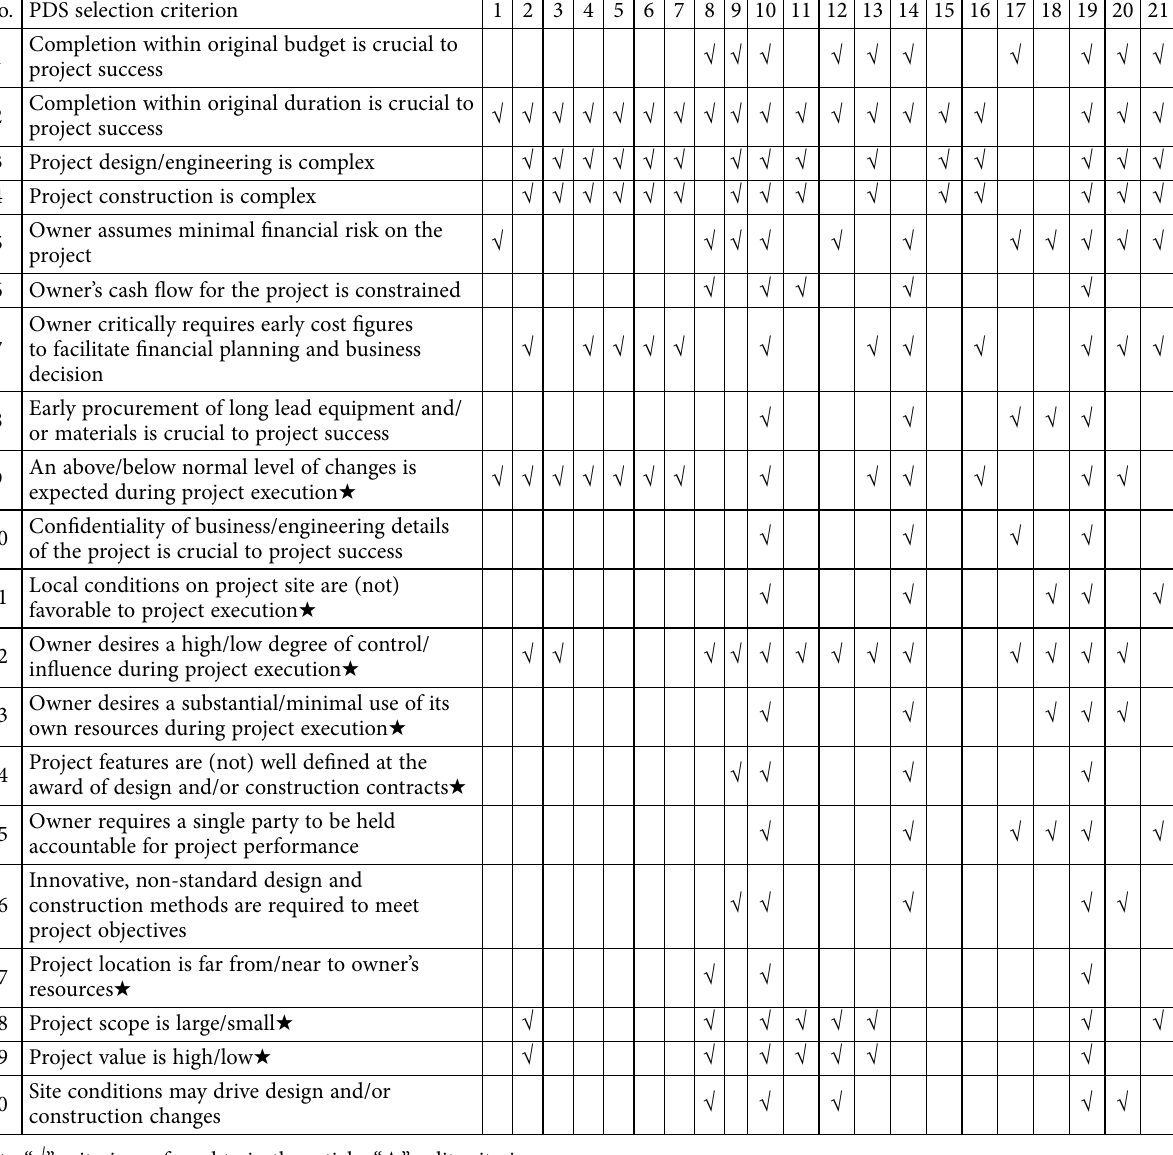
Table 3. Framework of PDS selection